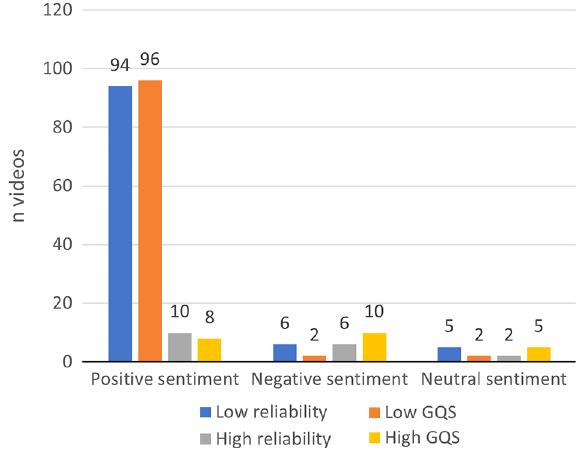
Figure 4. Reliability & GQS vs “Yes”